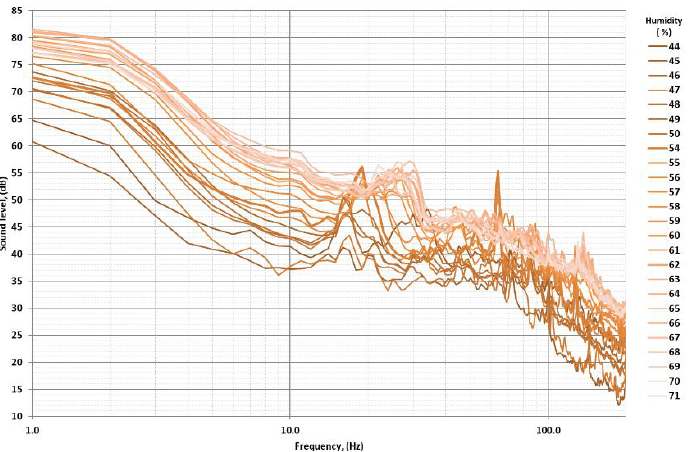
Figure 12. Course of amplitude spectra in the function of frequency for various temperatures—T2 turbine.